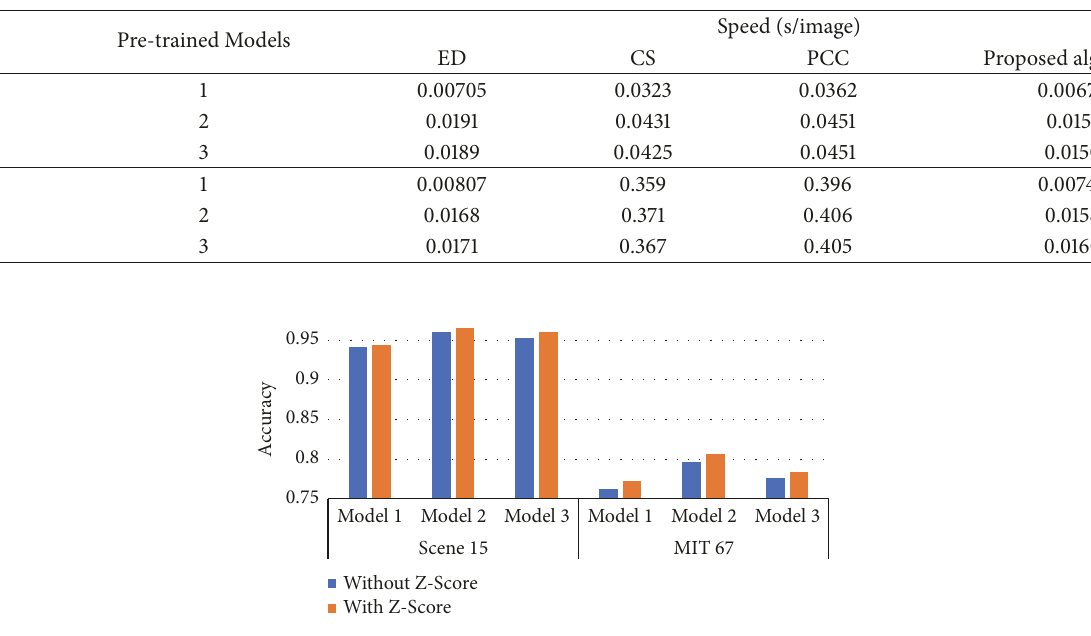
Table 4: Comparison between the proposed feature matching algorithm and correlative algorithms.